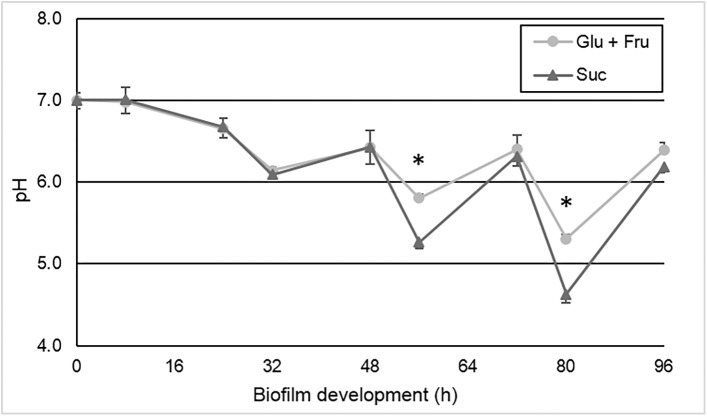
pH values of the culture medium according to the biofilm treatments (glucose + fructose or sucrose) and biofilm development time (h) as an indicator of biofilm acidogenicity.Time points at 80 h and 96 h refer to the harvest moment at abundance and starvation of carbohydrates, respectively. Asterisks indicate statistically significant difference between treatments at the time point evaluated (p < 0.05). (Means ± SD; n = 12).